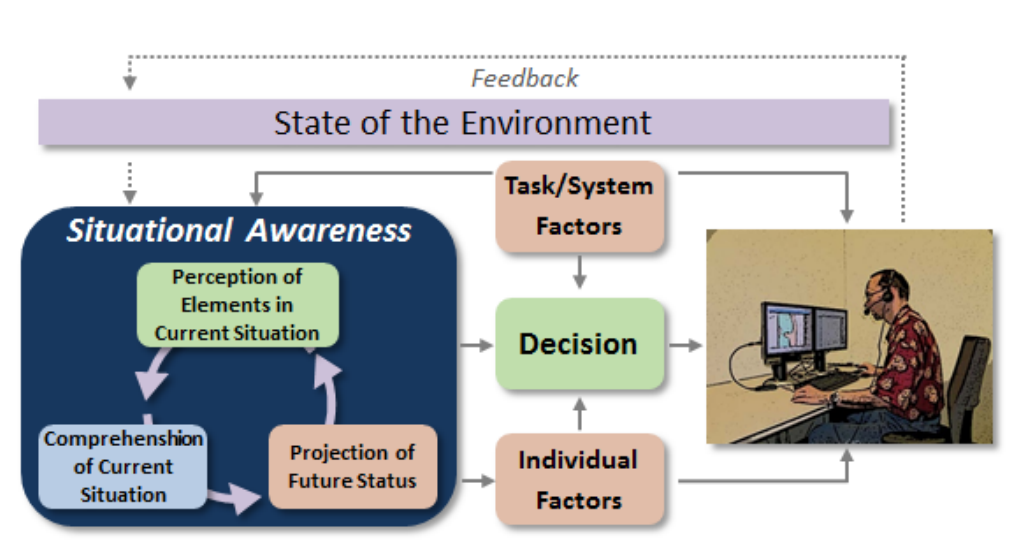
Figure 5: The process of decision-making for situation awareness. Situation awareness is defined as the human user’s internal conceptualization of a situation, which plays a key role in effective decision making. Figure adapted from [109]. Spatial data analysis and social network analysis can support decision-making from different perspectives, so the effective integration of both can enhance human user’s internal conceptualization of